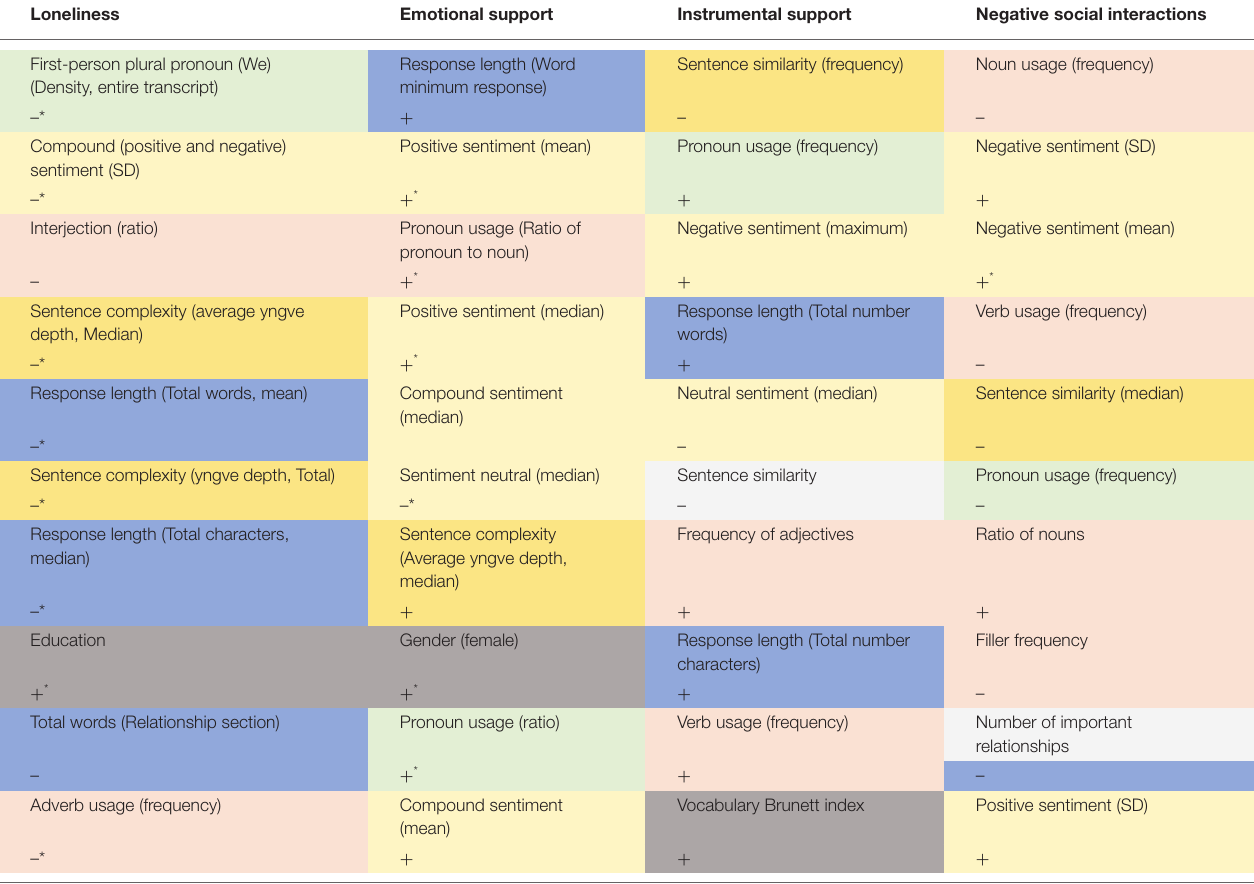
TABLE 4 | Top GINI-ranked predictors in machine learning models for loneliness and social isolation * #. Loneliness First-person plural pronoun (We) (Density, entire